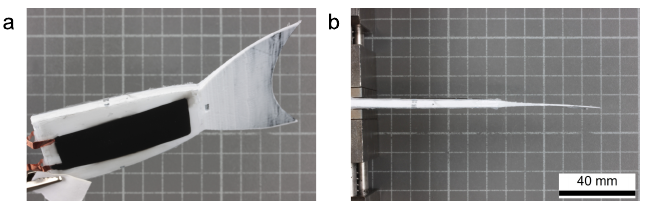
Figure 4. Assembled robotic setup. ( a ) General view with DEAs and electrical wiring and ( b ) top-view to illustrate the straight alignment due to the balanced pre-stretch ratios of the two DEAs.